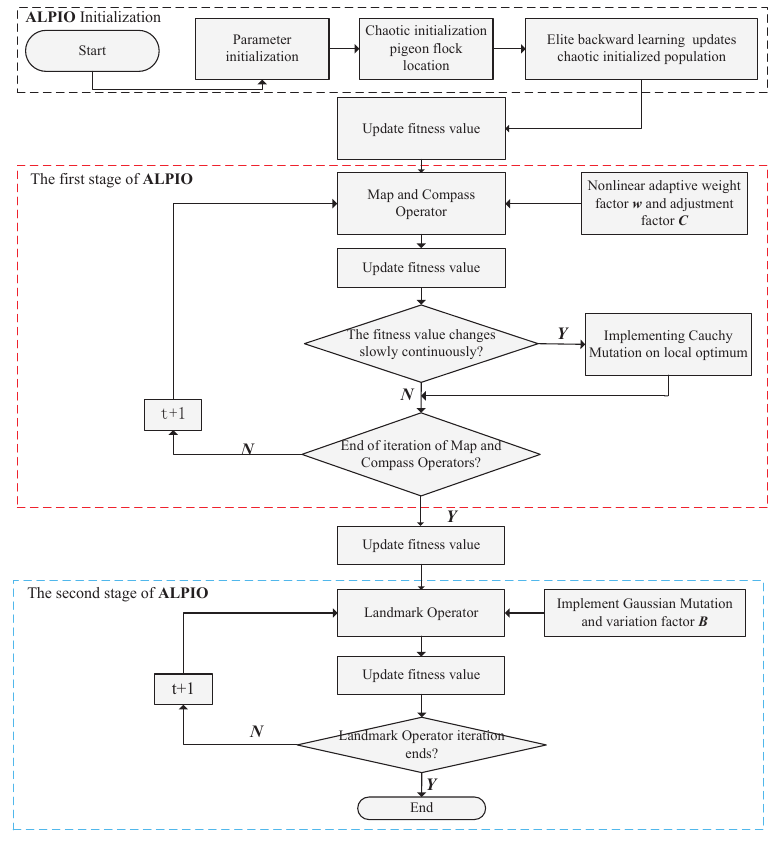
Figure 5. Block diagram of